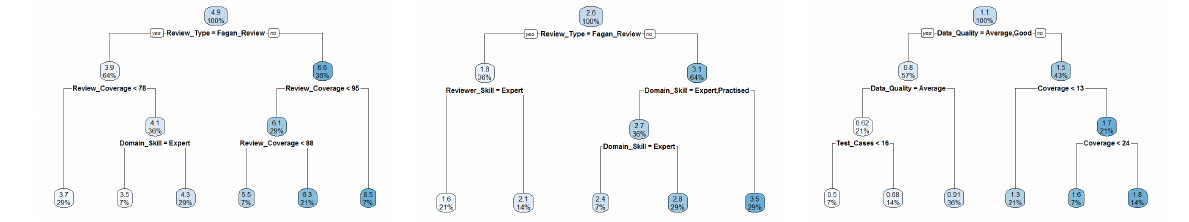
Fig. 4. Regression tree model for design review defect density